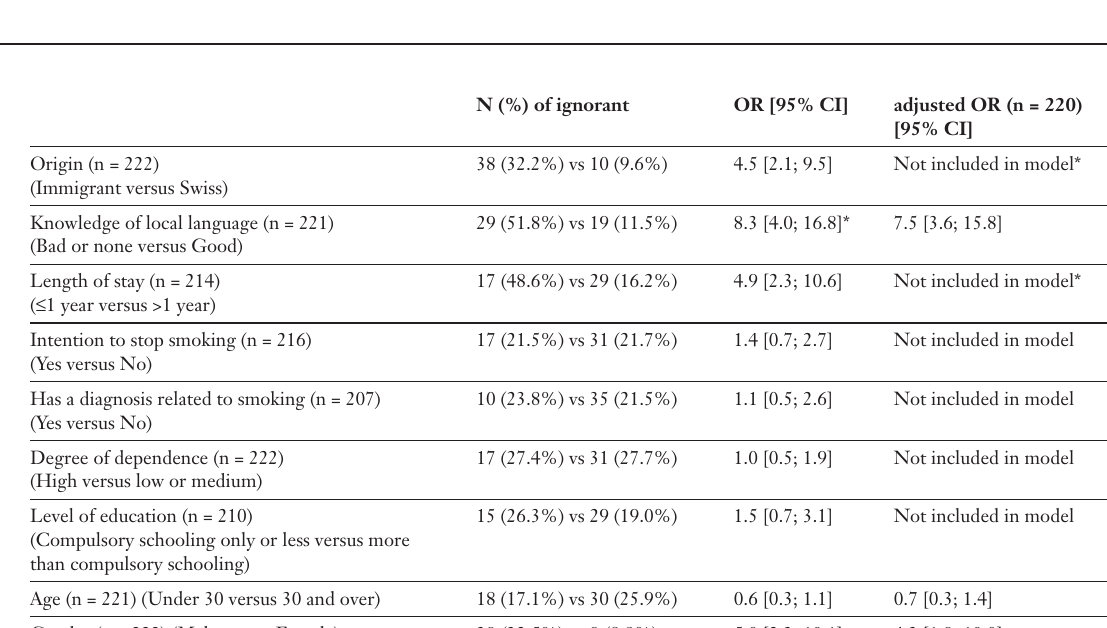
Gender, age, knowl- edge of smoking haz- ard and counselling on smoking cessation related to origin.